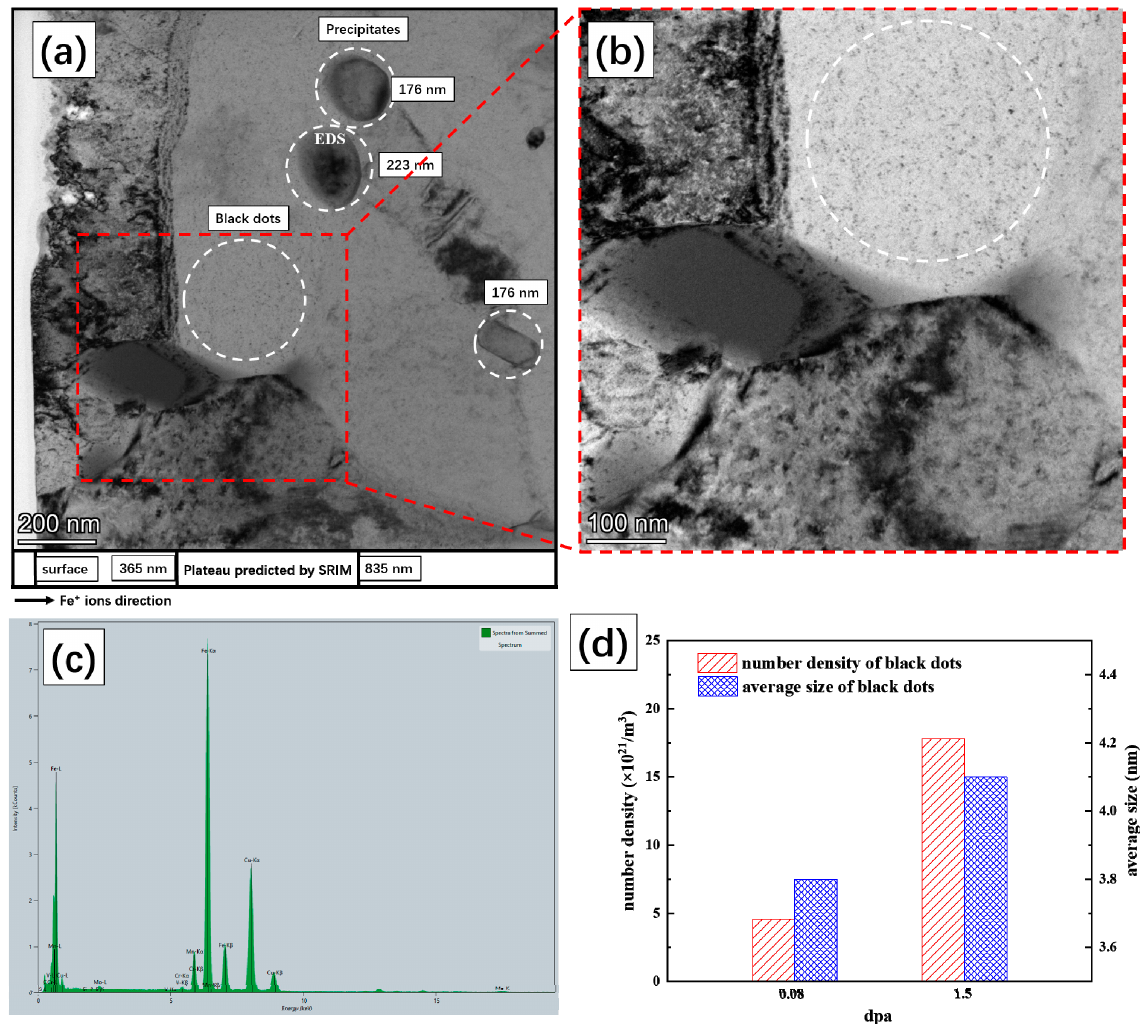
Figure 3. TEM bright field image ( a ), magnified image of black dots ( b ), and precipitate EDS results ( c ) of RPV steel at plateau damage level of 1.5 dpa; ( d ) the variation in number density and average size of black dots with dpa.